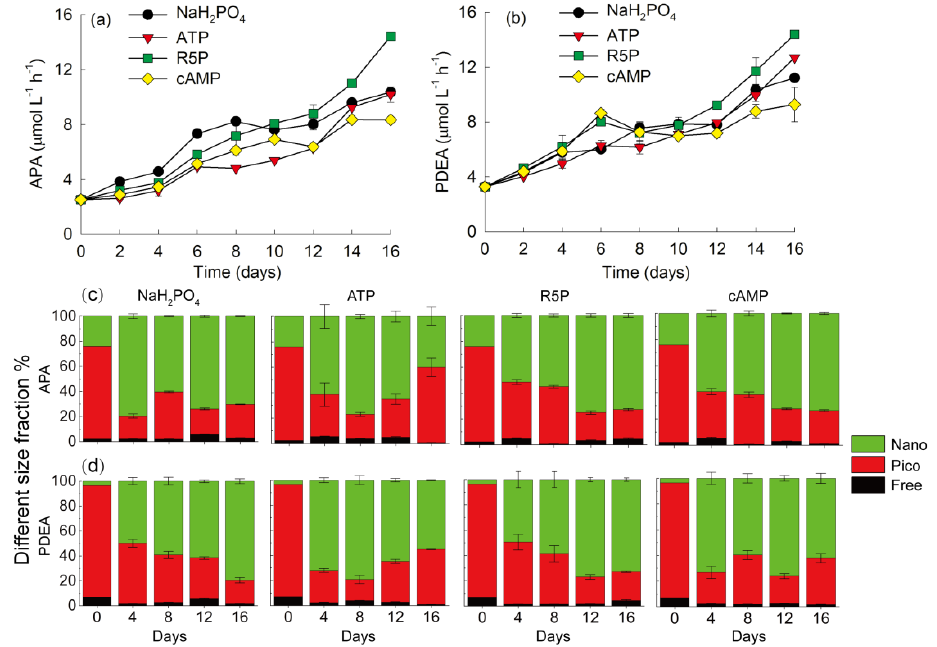
Figure 4. Alkaline phosphatase activity (APA) ( a ) and phosphodiesterase activity (PDEA) ( b ) and different size fractions of APA ( c ) and PDEA ( d ) of Karenia mikimotoi in the NaH 2 PO 4 , adenosine triphosphate (ATP), ribulose 5-phosphate (R5P), and cyclic adenosine monophosphate (cAMP) treatments. APA and PDEA are divided into three size fractions: free-sized, <0.22 µm, picosized, 0.22 – 2 µm, and nanosized, >2 µm. The values are the mean ± S.D. ( n = 3).